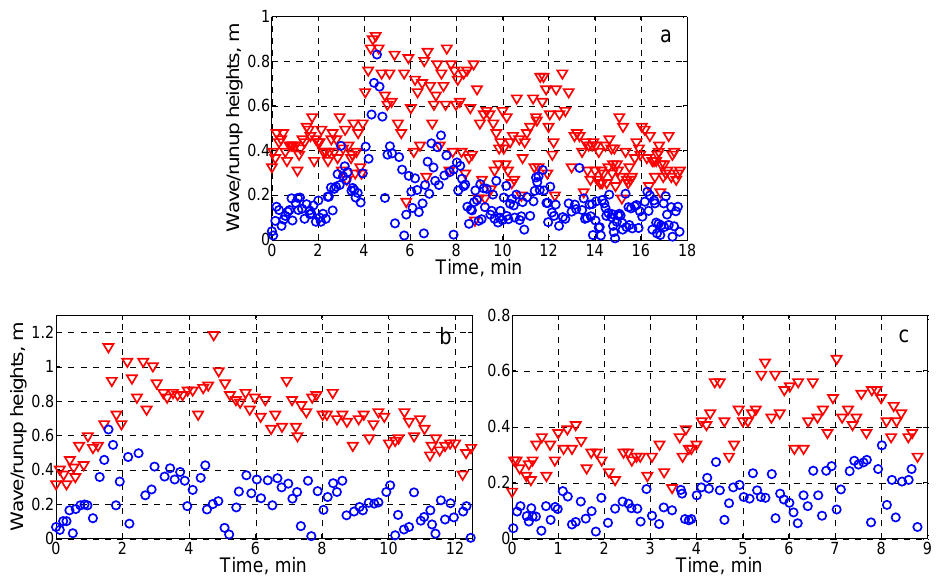
Fig. 9. Wave heights (blue circles) and corresponding run-up heights (red triangles) within the wake from a) “SuperStar” (19 June 2009, 19:15), b) “Star” (20 June 2009, 12:10) and c) “Viking XPRS” (21 June 2009, 13:50).